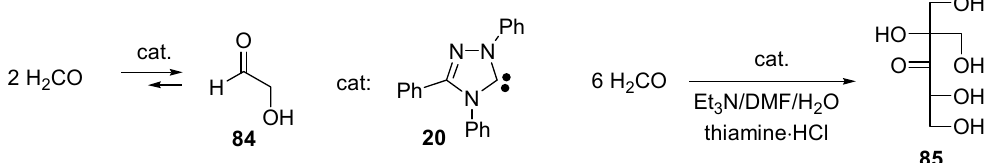
Figure 13. Structure of 86. The α‐ hydroxycarbonyl compounds are valuable synthetic intermediates. Cross ‐ condensation of two different aldehydes through the benzoin reaction represents the most direct route to these systems. Since all of the steps in the benzoin condensation are reversible, selectivity for the product of cross ‐ coupling depends on their relative stability with respect to the products of homocoupling. In most cases it remains small, thus selectivity in the product of cross ‐ coupling can be obtained only by using an excess of one of the two aldehydes. Using cyanide ‐ catalyzed benzoin reaction